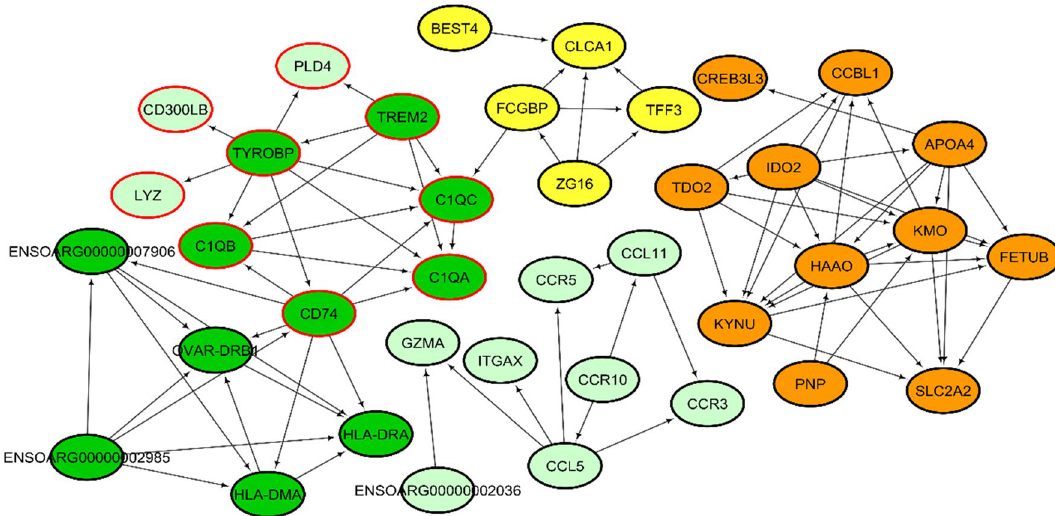
Figure 7. Protein–protein interaction (PPI) networks associated with down-regulated DEGs derived from STRING with subnetworks (SN) generated using the Cytoscape ClusterONE plugin. SN1 (dark green nodes); SN2 (orange nodes); SN3 (red bordered nodes); SN4 (yellow nodes); SN5 (blue bordered